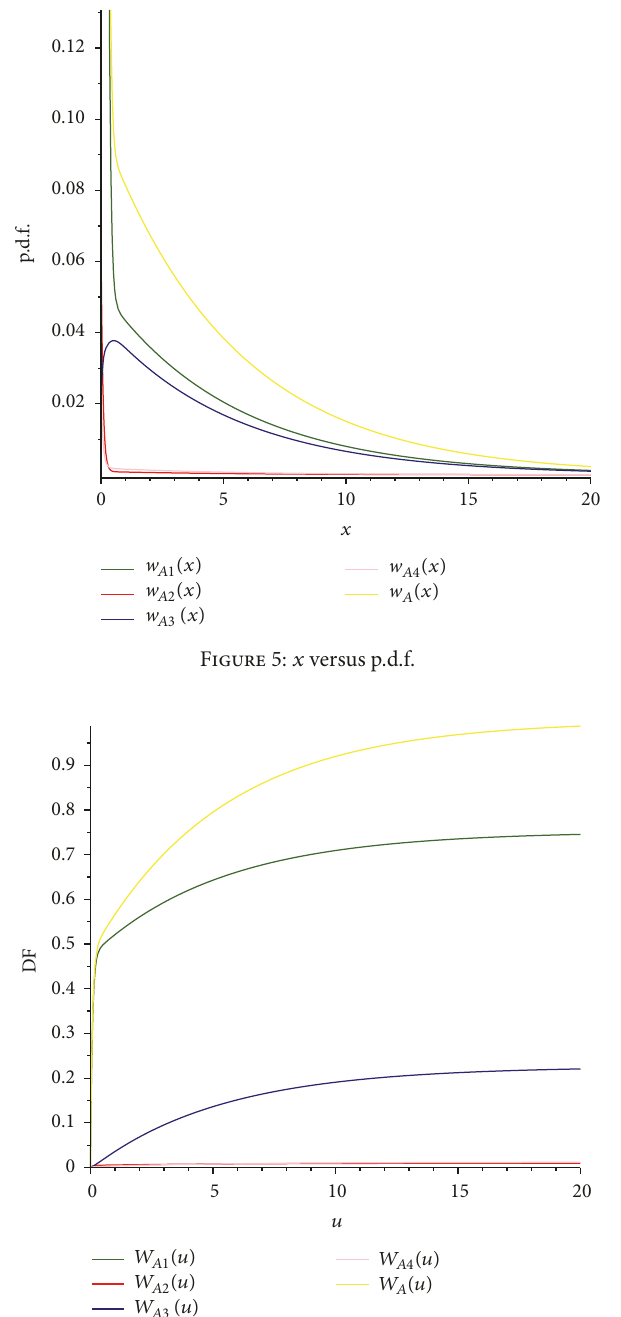
Figure 6: 𝑢 versus distribution